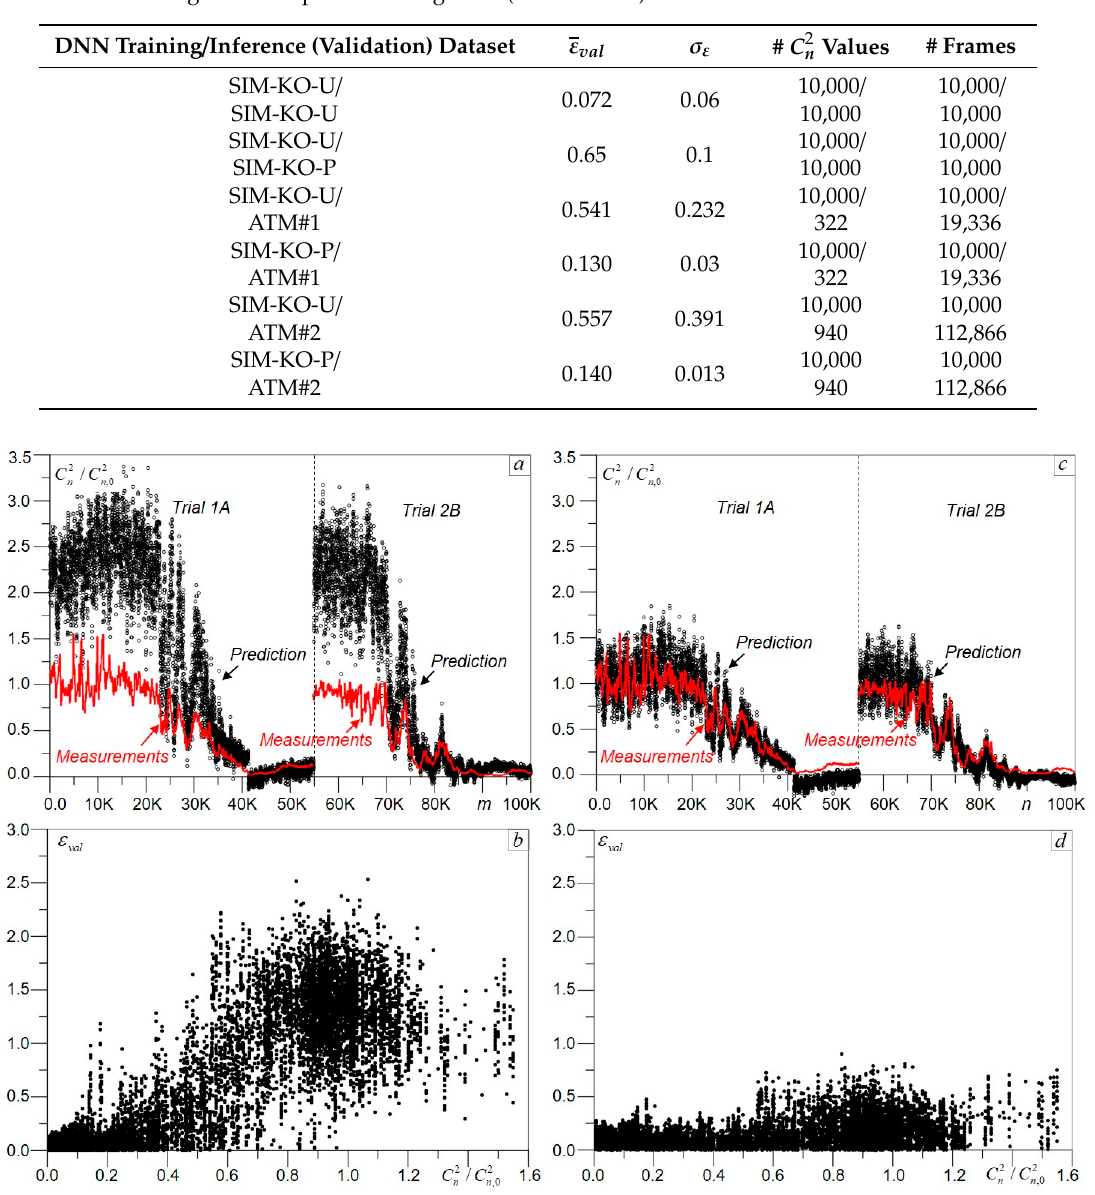
Table 3. Averaged C 2 n prediction error ε val and its standard deviation σ ε for Cnˆ2Net models trained using simulated datasets corresponding to the Kolmogorov turbulence model with uniform (SIM-KO-U) and unevenly distributed (profiled) along the propagation path (SIM-KO-P) refractive index structure parameter. Predictions of the C 2 n values measured with a scintillometer were performed in cross-dataset machine learning experiments using scintillation images from ATM#1 and ATM#2 inference datasets collected during the atmospheric sensing trials (see Section 2).